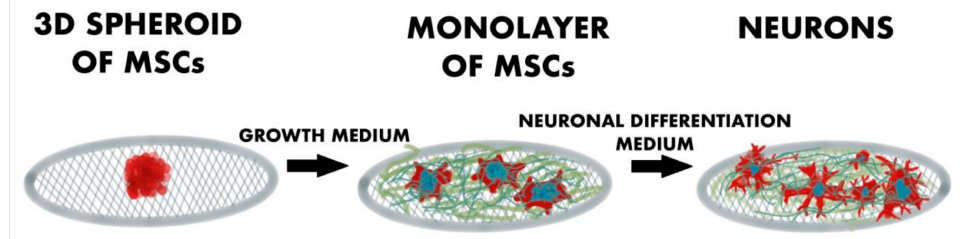
Figure 2. Visual schematic demonstrating the test process of the spheroid formation and neuronal differentiation of hMSCs using high-quality